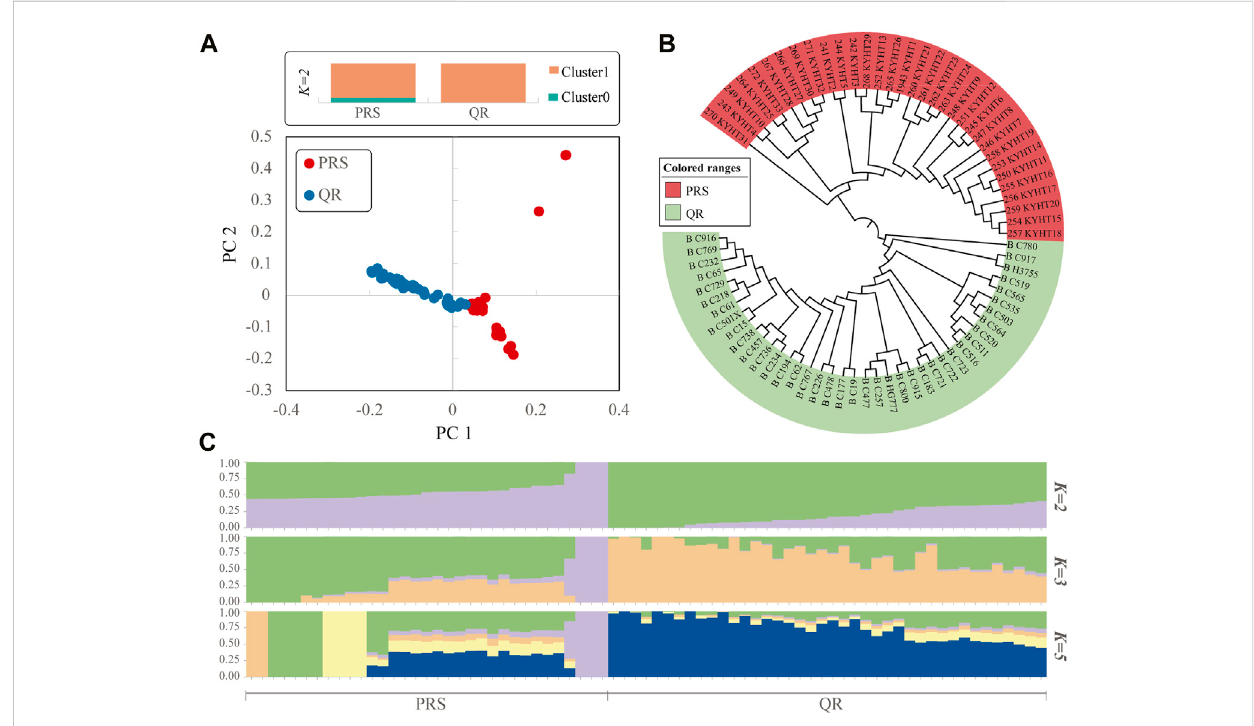
FIGURE 2 Analysis of the population structure in PRS and QR. (A) , Principal component analysis, k-means clustering was carried out according to the prede fi ned subsets. (B) , Neighbor-joining tree. (C) , Analysis of Admixture with the assumed number (K = 2, 3 and 5).